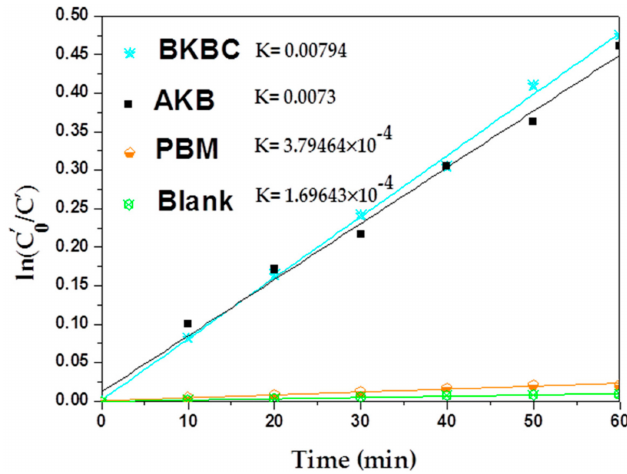
Figure 10. Kinetic process of MB degradation for AKB, BKBC, PBM, and blank.